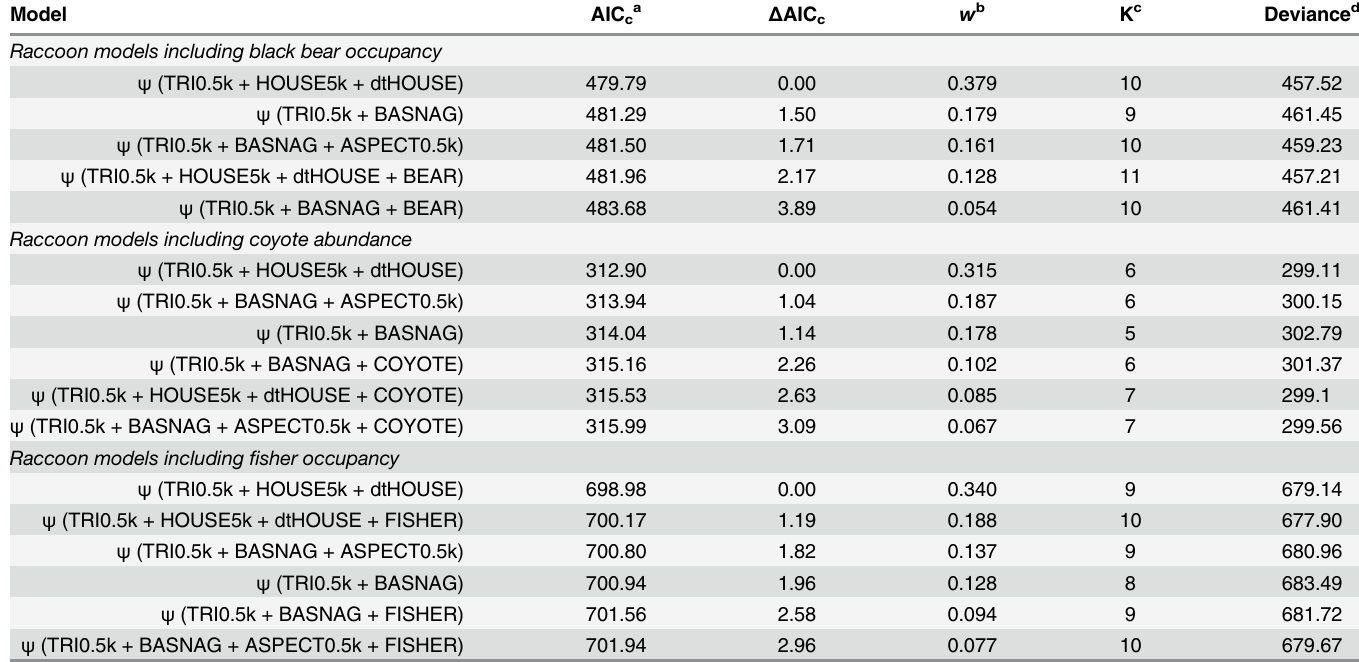
Table 3. Raccoon co-occurrence models. Co-occurrence model selection results in the 90% confidence set for P . lotor with the inclusion of U . americanus , C . latrans , and M . pennanti . We fit encounter history data from surveys at 54 sites in Adirondack Mountains, New York, USA to each candidate model set. Co-occurrence models were fit using important detection parameters and estimated occupancy, except C . latrans models which were fit using estimated abundance. See S1 Table for habitat variable